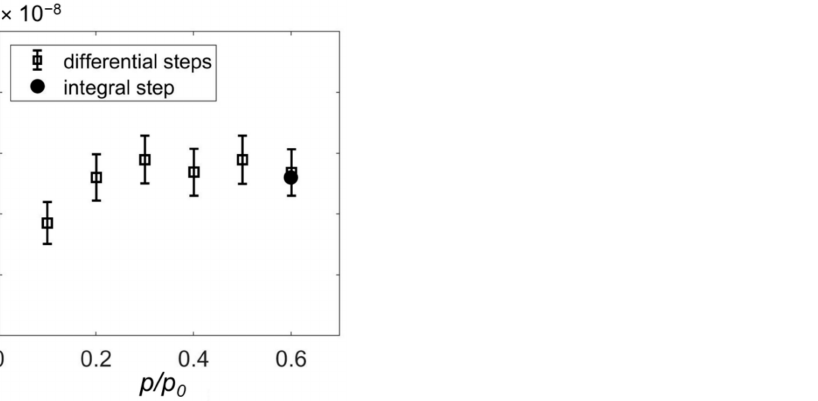
Figure 5. Values of water–PEI mutual diffusivity, D 12 , determined from FTIR spectroscopy reported as a function of relative pressure of H 2 O vapor at 303.15